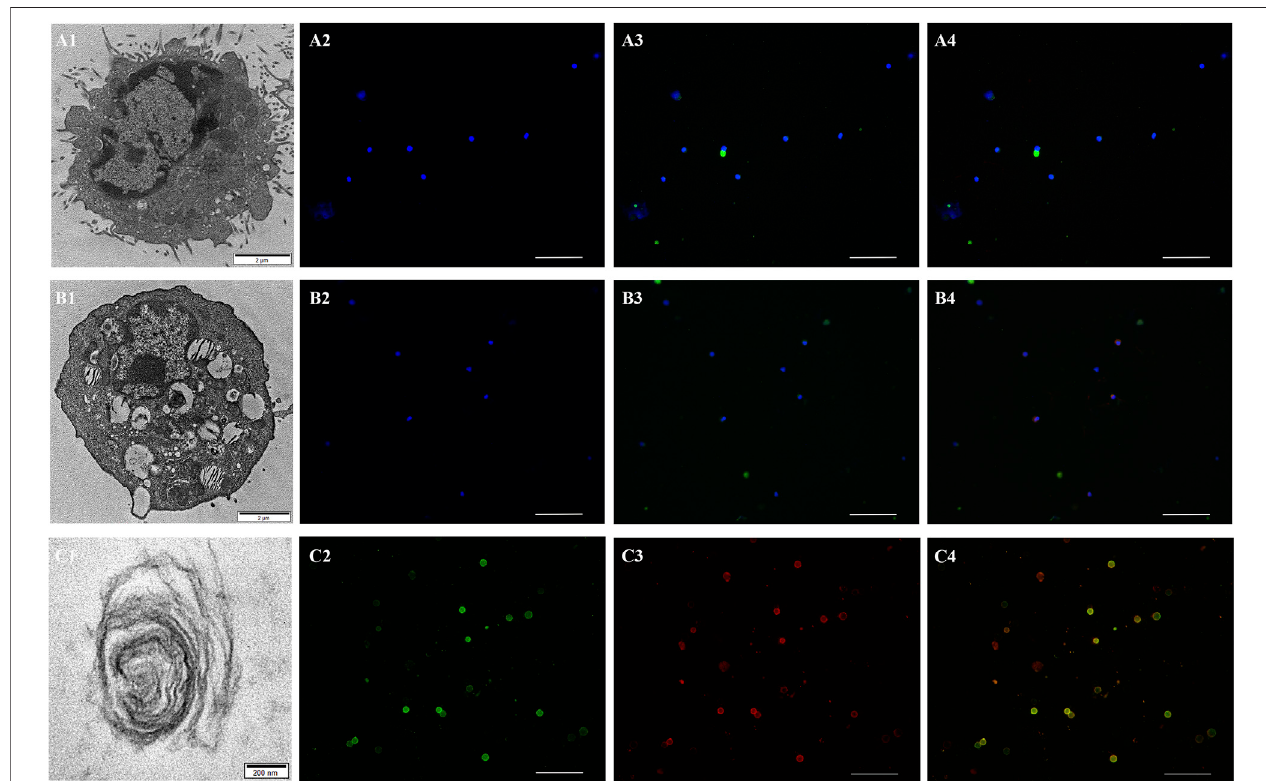
FIGURE 4 | The expression of γ -like subunit in ATI, ATII and LBs of plateau zokor. (A1,B1,C1) Transmission electron microscopy (TEM) patterns of the ATI (A1) , ATII (B1) ,andLB (C1) ofplateau zokors. (A2,B2) ThecontrolsoftheATI (A2) andATII (B2) ofplateauzokors. (A3,B3) Immuno fl uorescencestainingoftheAQP-5inATI (A3,green)andSP-CinATII(B3,green)ofplateauzokors. (A4,B4) Immuno fl uorescencestainingofthe γ -likesubunitinATI(A4,green+red)andATII(B4,green+red)of plateau zokors. The DAPI labeled the nucleus blue; objective magni fi cation: ×20, scale bar = 100 μ m. (C2,C3,C4) Immuno fl uorescence staining of the SP-C (C2, green), γ -like subunit (C3, red), and SP-C + γ -like subunit (C4, green + red) in LBs of plateau zokors. Objective magni fi cation: ×40, scale bar = 100 μ m.